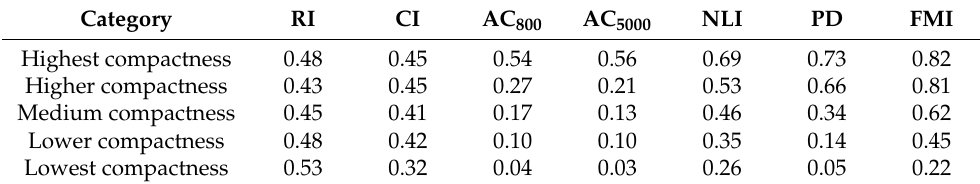
Table 6. The average value of each indicator for the five types of PUAs.